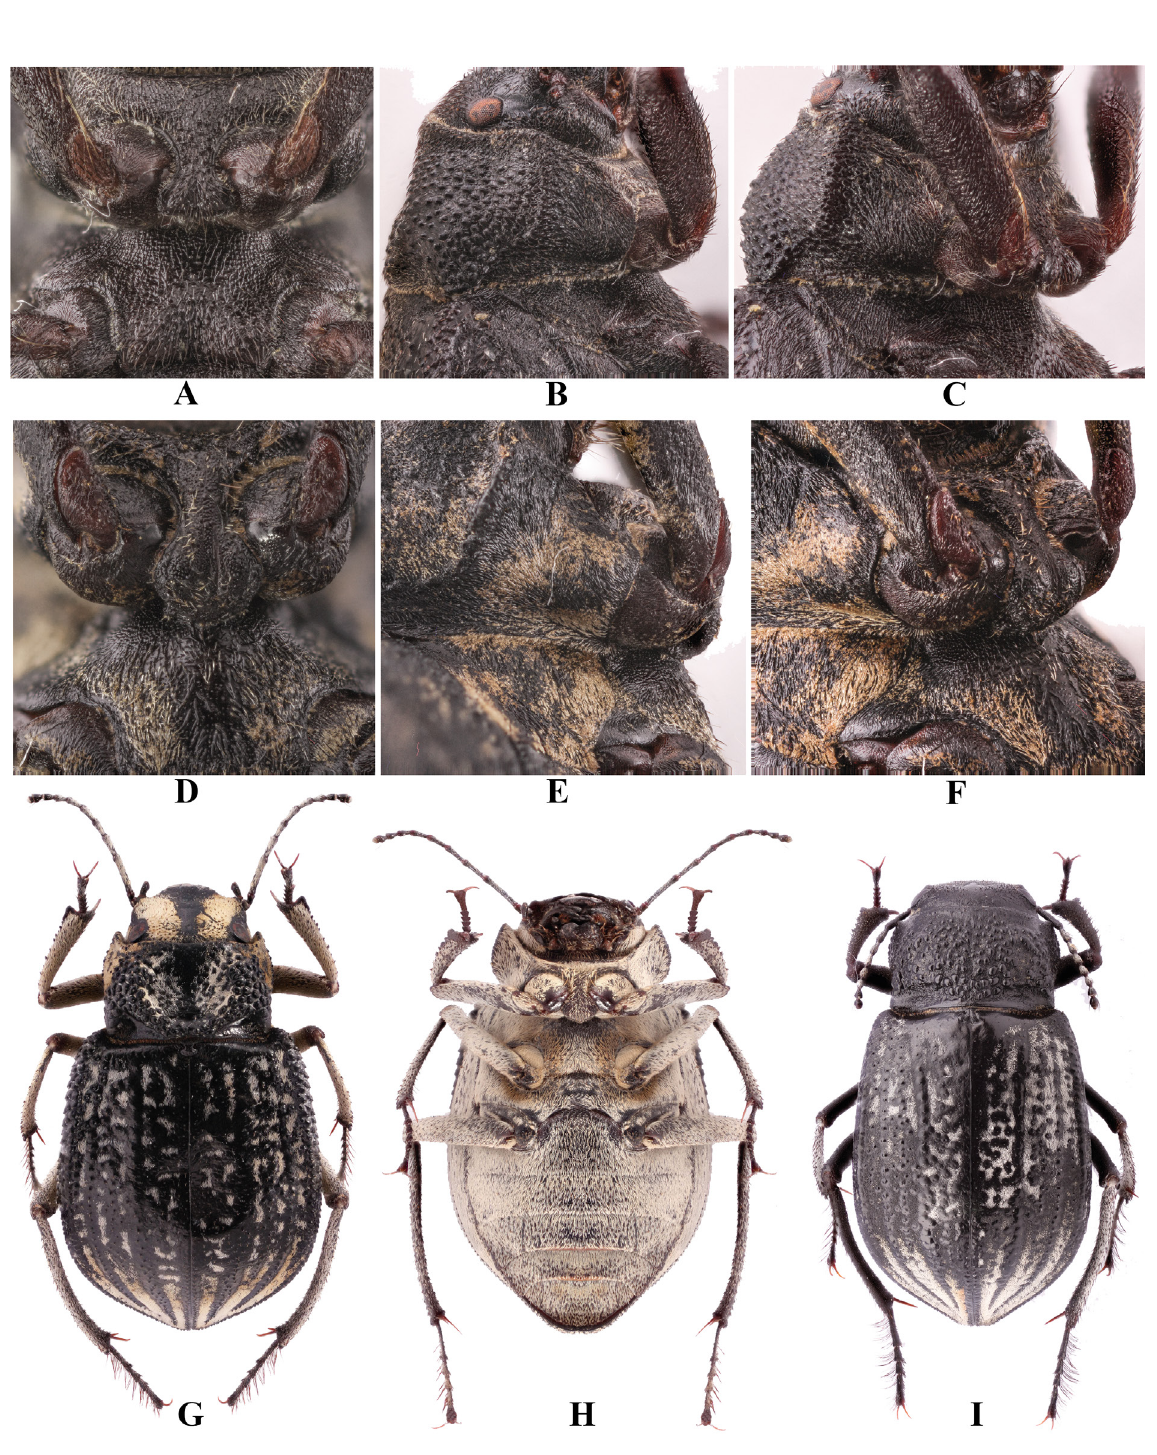
Fig. 5. Species of the genus Platyope Fischer von Waldheim, 1820, details of structure and habitus. A . P. leucogramma (Pallas, 1773), ♂ (ZIN), prosternal process, ventral view. B . Ditto, ventral view. C . Ditto, dorso-lateral view. D . P. grumi (Semenov, 1893), ♂, paralectotype (ZIN), prosternal process, ventral view. E . Ditto, lateral view. F . Ditto, dorso-lateral view. G. Ditto, habitus, dorsal view. H . Ditto, ventral view. I . P. granulata Fischer von Waldheim, 1820, ♂ (ZIN), habitus, dorsal